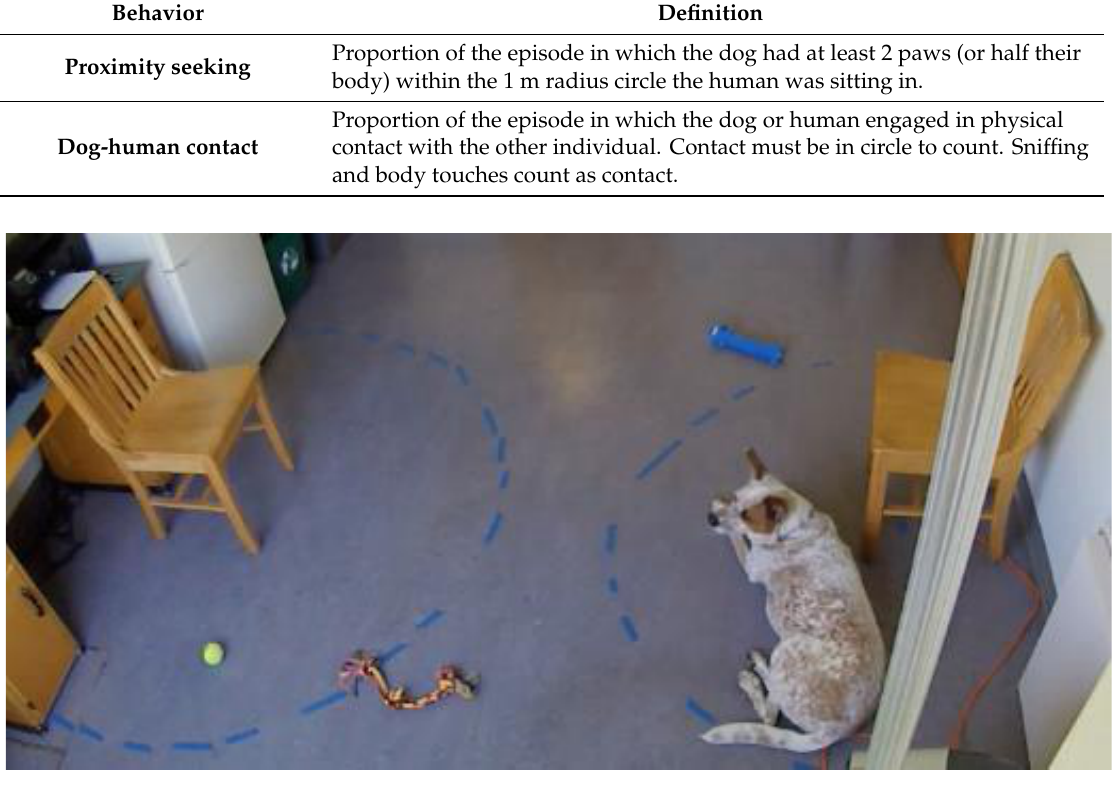
Figure 1. Paired attachment test set-up.